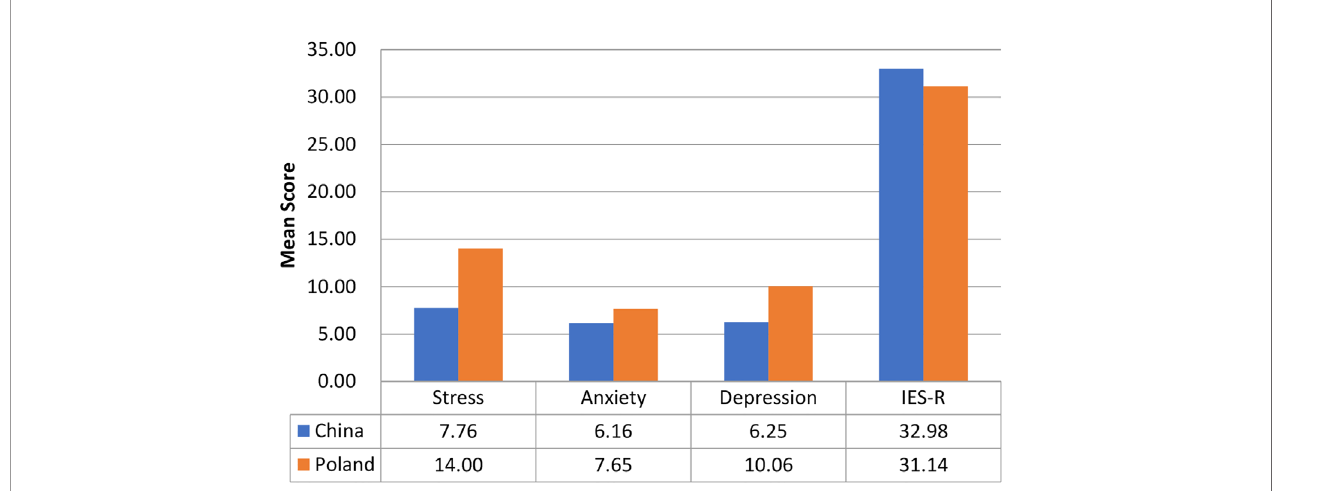
FIGURE 1 | Comparison of the mean scores of DASS-stress, anxiety, and depression subscales as well as IES-R scores between Polish and Chinese respondents (N =